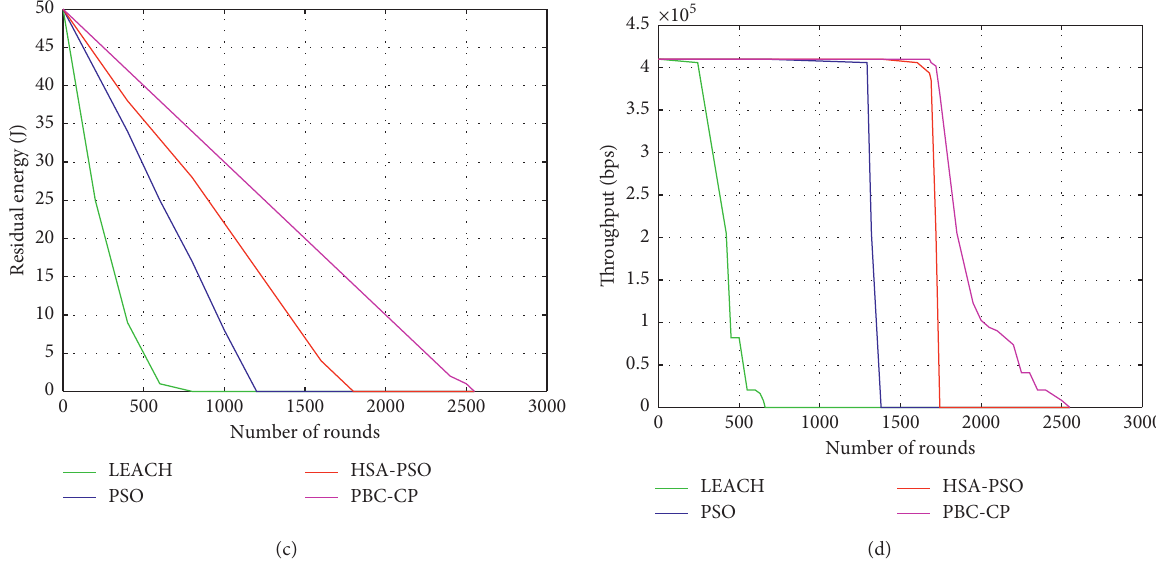
Figure 3: (a) Number of alive nodes vs number of rounds in different protocols. (b) Number of dead nodes vs number of rounds in different protocols. (c) Comparative analysis of PBC-CP in terms of residual energy with different rounds. (d) Comparative analysis of PBC-CP in terms of throughput with different